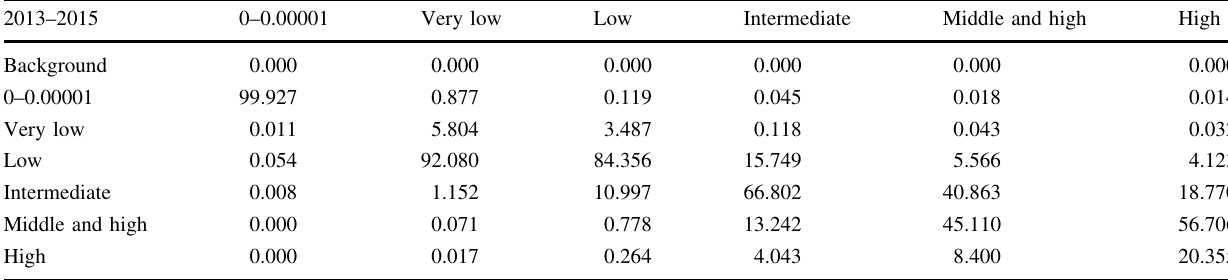
Table 4 Transform situation matrix of vegetation (%) 2013–2015 Background